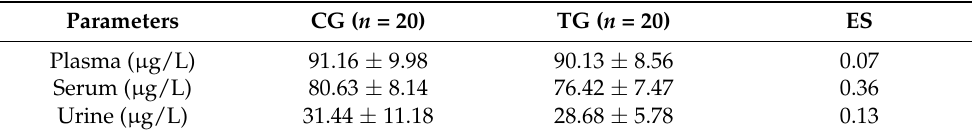
Table 4. Plasma, serum and urinary concentrations of Se.